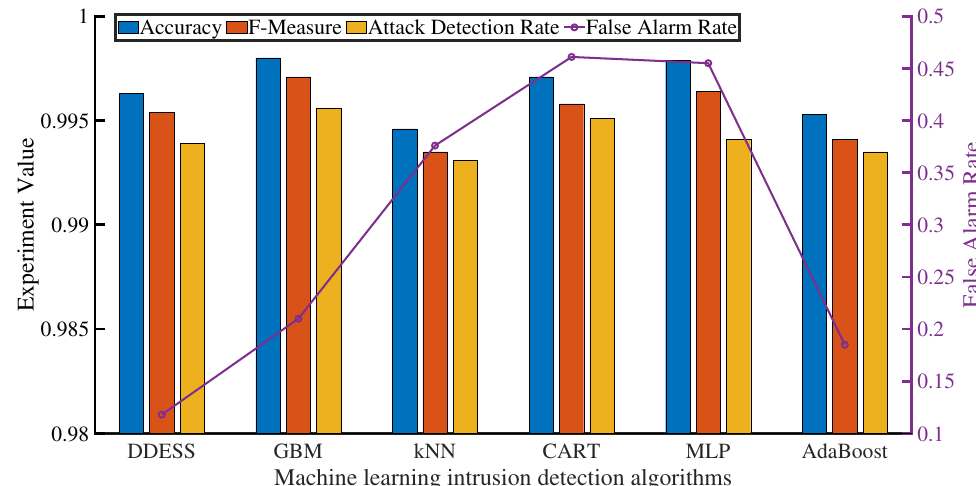
Figure 8. Performance comparison of intrusion